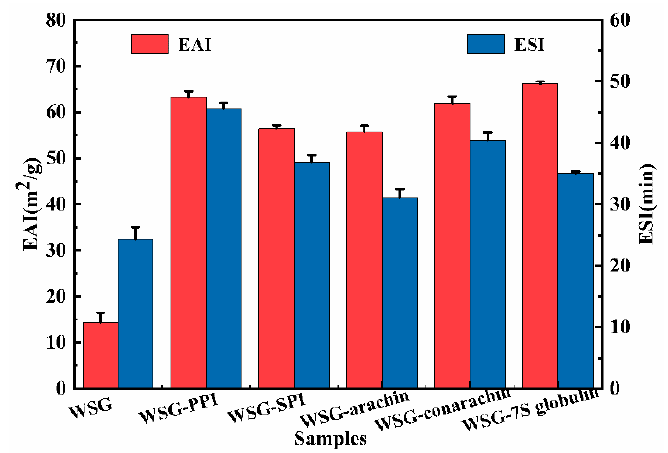
Figure 1. Emulsifying properties of WSG and its conjugates.